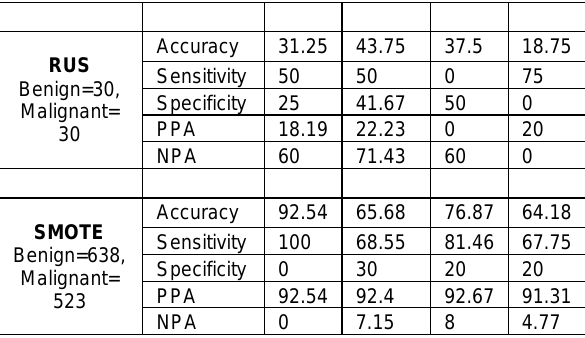
Table 4(d) Result for target Variable